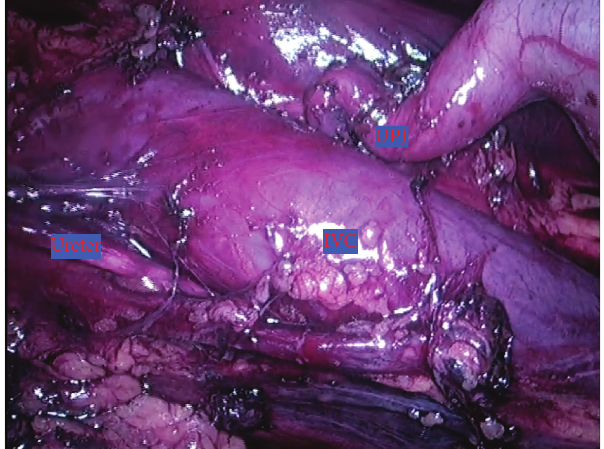
Figure 5: Starting the anastomosis, first on the posterior side with running